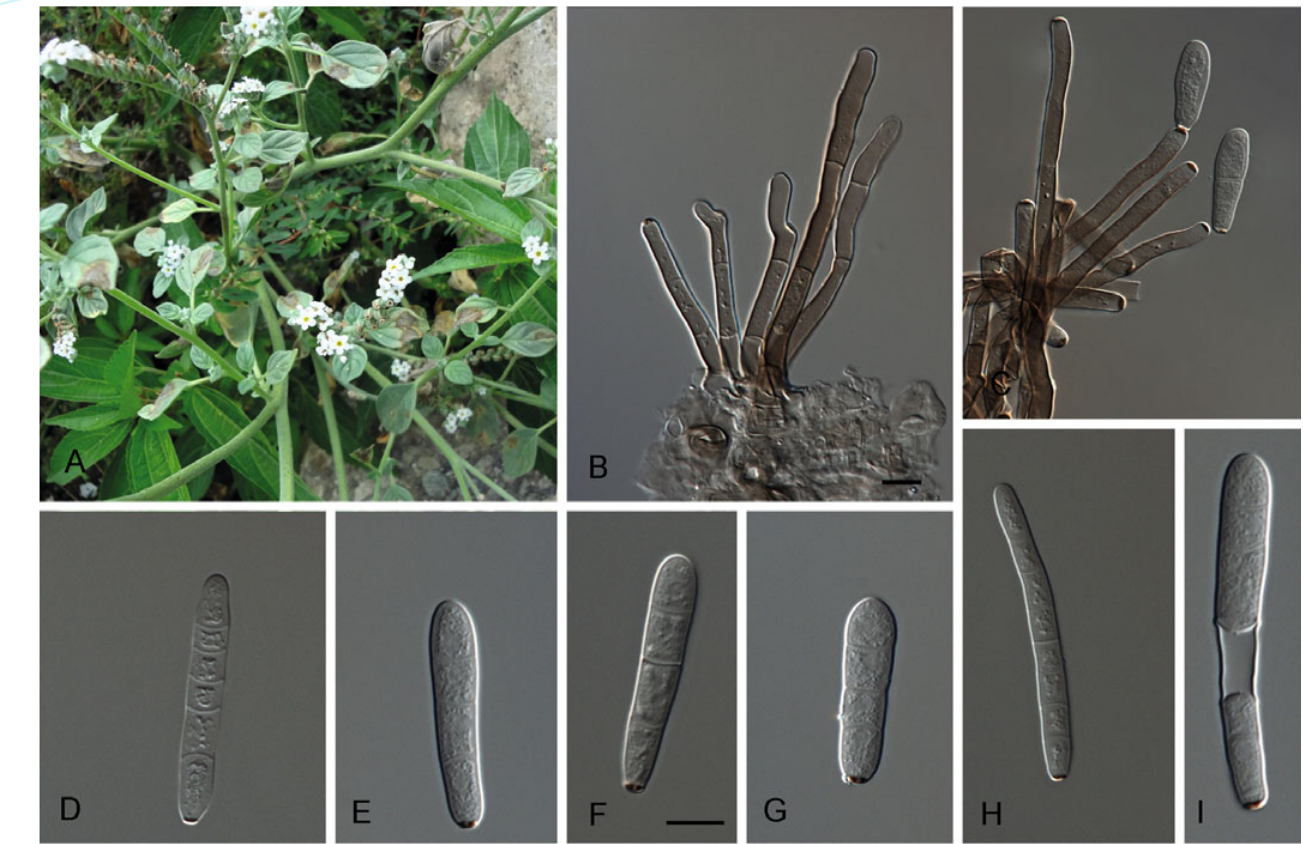
Fig. 4. Cercospora uwebrauniana (cid:2)(cid:24)%’7(cid:2)!.303!(cid:27)(cid:28)(cid:2) A. (cid:2)S(cid:13)(cid:9)(cid:26)(cid:2)(cid:7)(cid:18)(cid:4)(cid:8)(cid:7)(cid:28)(cid:2) B–C. (cid:2)2(cid:9)(cid:7)(cid:19)(cid:11)(cid:19)(cid:5)(cid:23)(cid:9)(cid:8)(cid:13)(cid:2)(cid:19)(cid:4)(cid:17)(cid:11)(cid:21)(cid:11)(cid:4)(cid:18)(cid:14)(cid:4)(cid:10)(cid:13)(cid:7)(cid:28)(cid:2) D–I. (cid:2)%(cid:4)(cid:17)(cid:11)(cid:21)(cid:11)(cid:9)(cid:28)(cid:2)’(cid:9)(cid:10)(cid:7)(cid:2)(cid:134)(cid:2)!+(cid:2)_(cid:6)(cid:28)